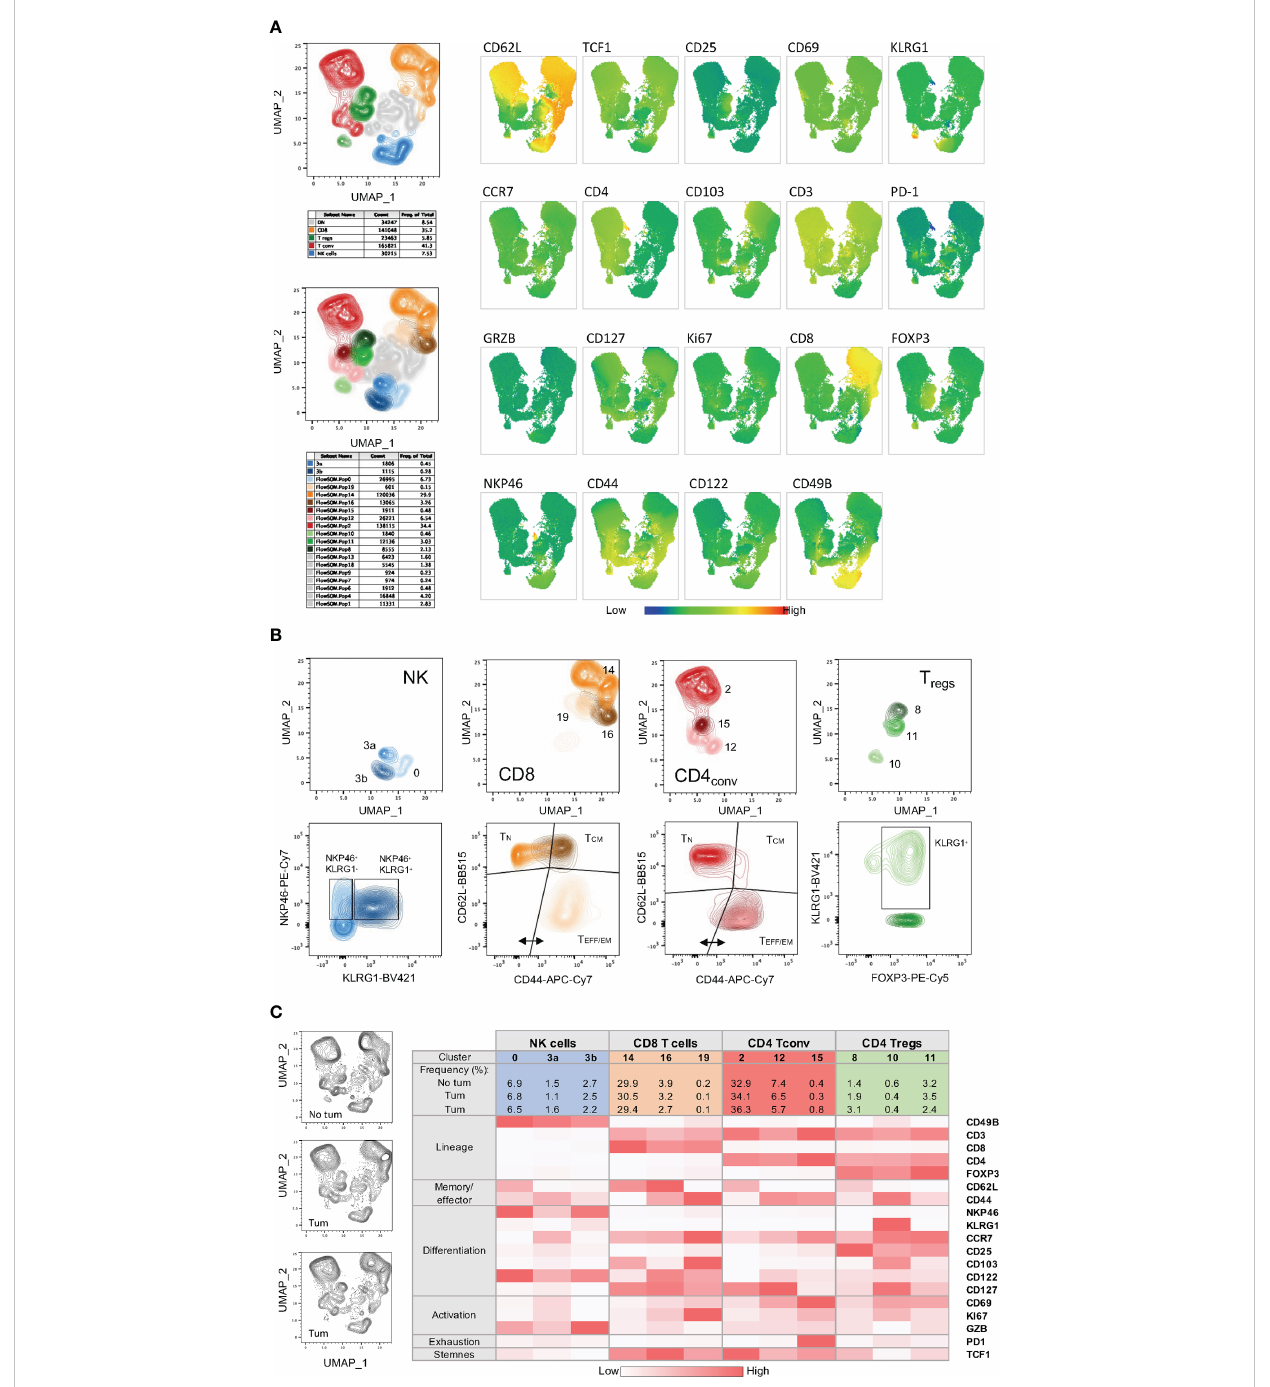
FIGURE 6 High-dimensional data analysis on splenocytes from mice bearing YUMM UV 1.7 tumors and stained with Panel 2. (A) Top left: UMAP plot on concatenated T and NK cells from 3 spleens isolated from C57Bl/6 mice bearing YUMM UV 1.7 tumours. The plot shows overlayed coloured manual gates for CD8 + T cells (orange), CD4 + T conv cells (red), CD4 + T reg cells (green), NK cells (blue), and double negative (CD4 - CD8 - ) T cells (grey). Contour plots reveal cell density and main subpopulations. Bottom left: Same UMAP as in the top plot where cells are color-coded according to the 17 main clusters identi fi ed with FlowSOM and additional sub-clusters (3a and 3b) manually de fi ned. Right: visualization of the expression phenotype across all T and NK cell clusters in UMAP. Marker expression intensity is indicated by the scale bar at the bottom of the plots where blue is low and red is high. Each marker is indicated above each plot. (B) Top plots: UMAP plots showing clusters and sub-clusters in the 4 main immune cell population: CD8 + , CD4 + T conv , CD4 + T regs and NK cells. Bottom plots: same clusters and sub-clusters analysed for maturation and differentiation markers. (C) Left: UMAP plots from individual spleens. Right: MFI heatmap for the indicated markers across the 4 main immune cell population and within each cluster and sub-cluster obtained with FlowSOM or manually de fi ned. Marker expression intensity is indicated by the scale bar at the bottom of the table where white is low and red is